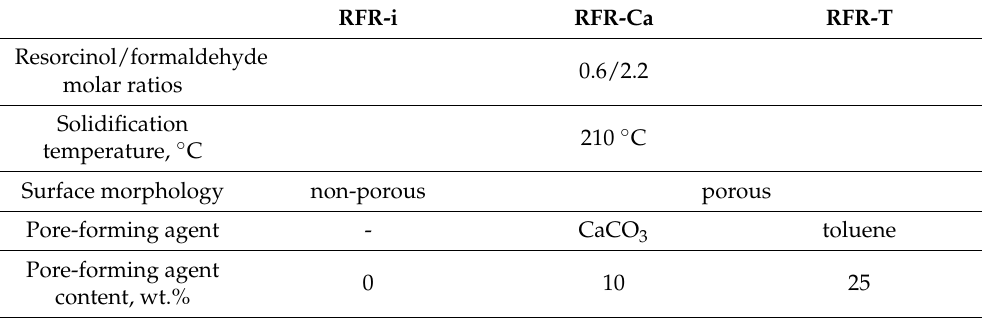
Table 5. RFR synthesis conditions and samples notations.